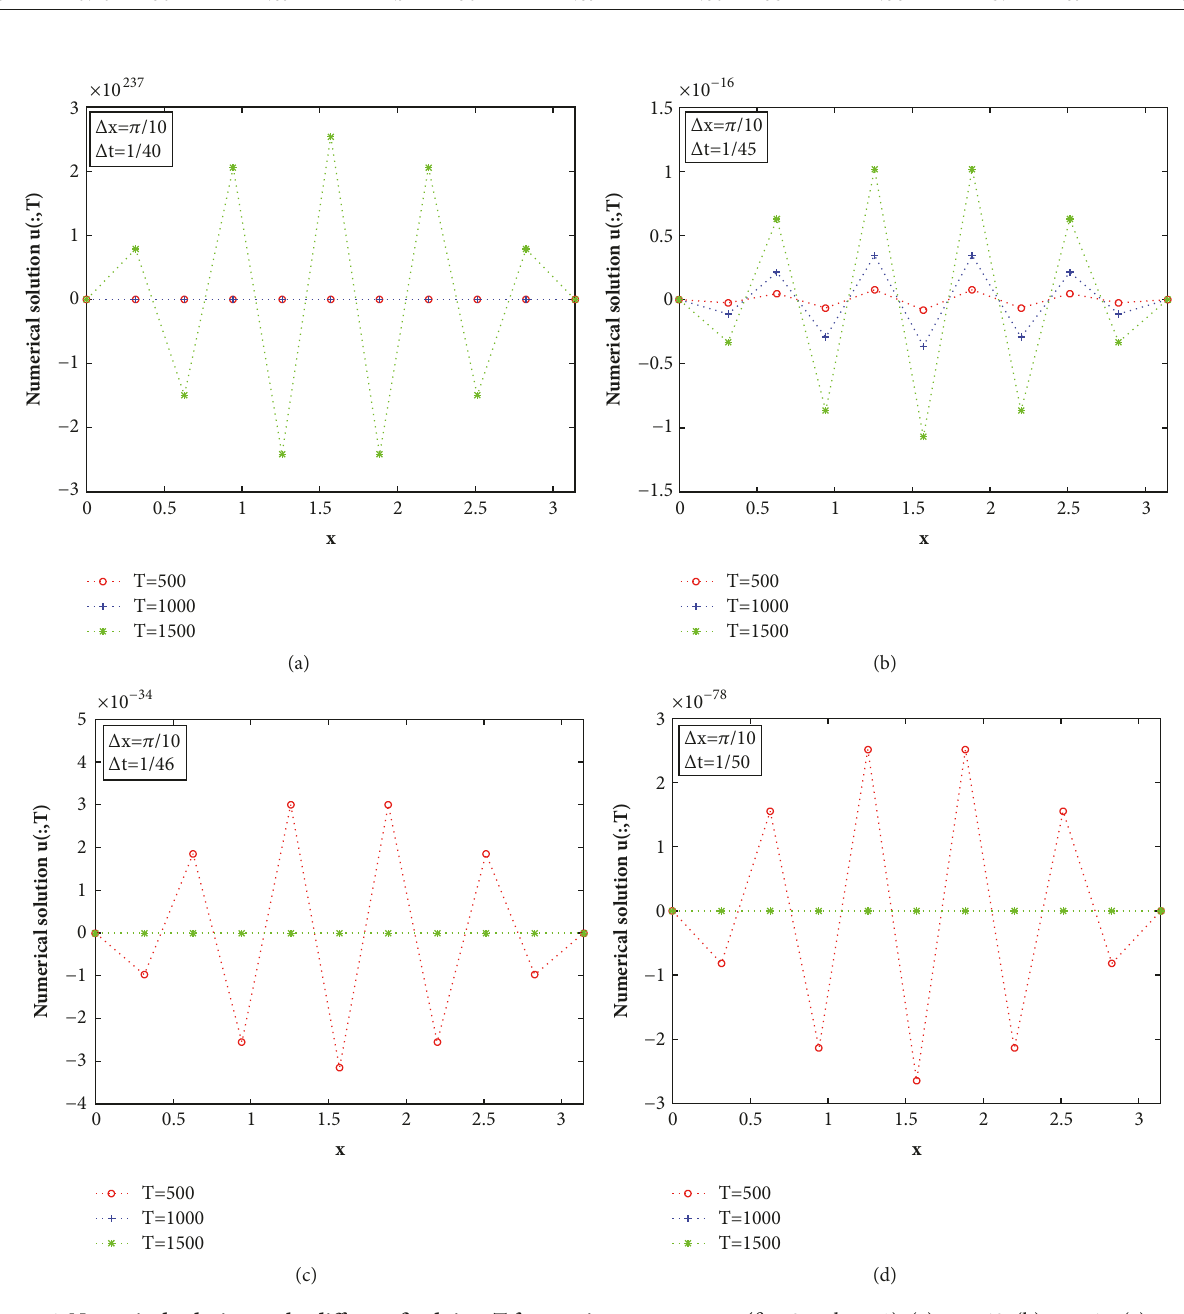
Figure 4: Numerical solution at the different final time T for varying parameter 𝑚 ( 𝜃 = 0 and 𝜏 = 1 ). (a) 𝑚 = 40 . (b) 𝑚 = 45 . (c) 𝑚 = 46 . (d) 𝑚 = 50